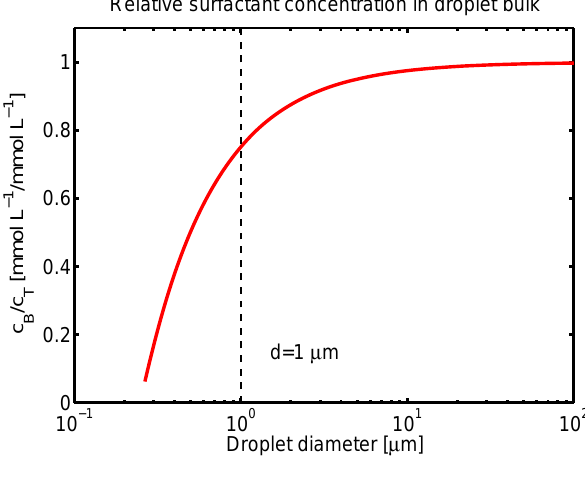
Fig. A1. Ratio of surfactant bulk ( c B ) and total ( c T ) molarities as a function of droplet diameter ( d ). Droplets of all sizes have fixed total surfactant molarity c T = 40mmolL − 1 and surfactant surface excess 0 = 10 18 m − 2